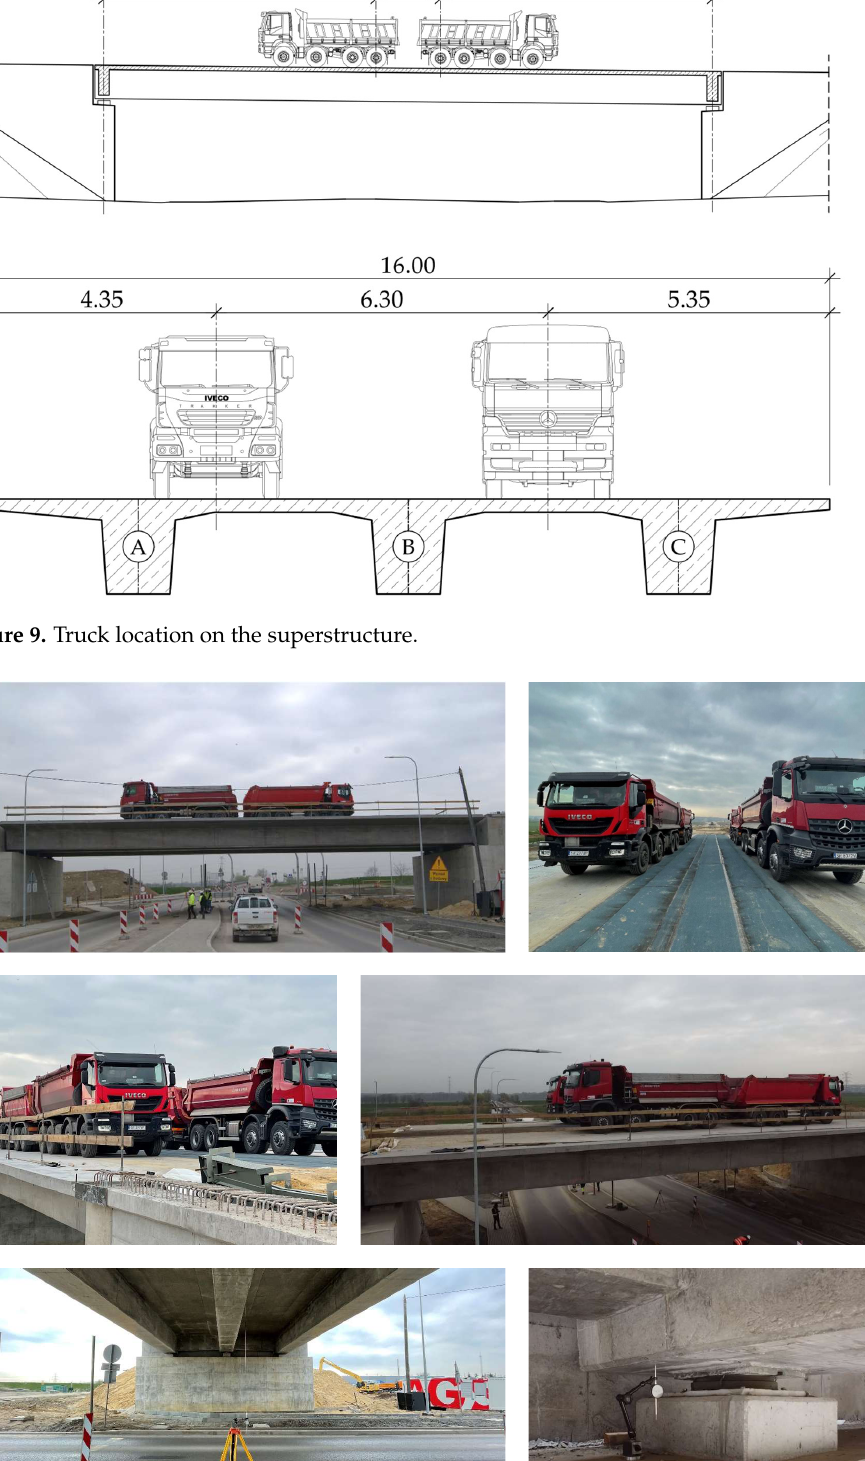
Figure 11. Division of the model into finite elements: beams (yellow) and plates (blue). Numerical analyses were performed using different values of the modulus of elastic- ity: the standard value and those obtained from laboratory tests. The load of the trucks was modeled as pressure on the wheel-structure contact surface (Figure 12).